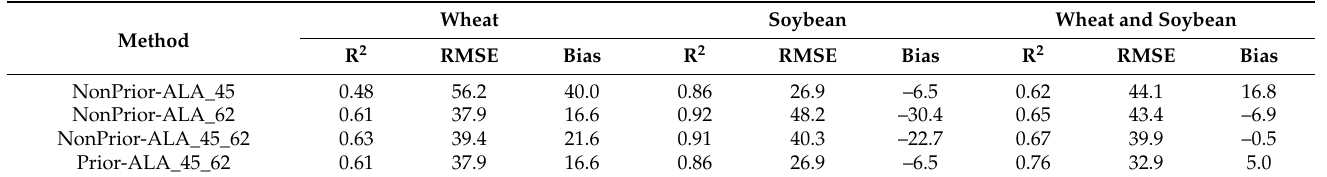
Table 5. Statistical results of the CCC retrieval accuracy for wheat and soybean